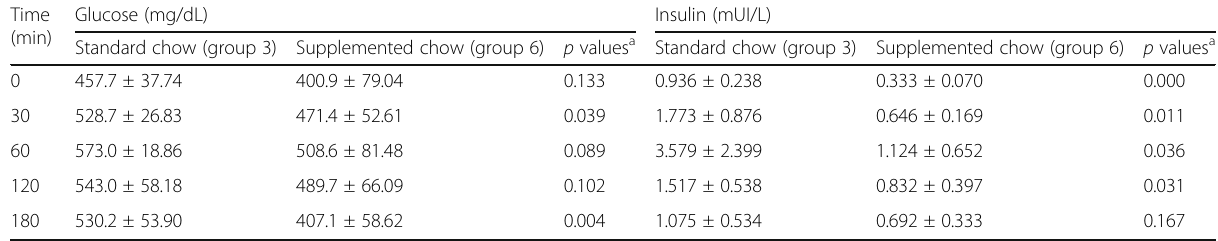
Table 6 Glucose and insulin concentrations obtained after the administration of an oral 3 g glucose load to diabetic rabbits ( n = 6) treated with oral metformin (30 mg/kg) and Plantago ovata husk (300 mg/kg) Time Glucose (mg/dL) Insulin (min)